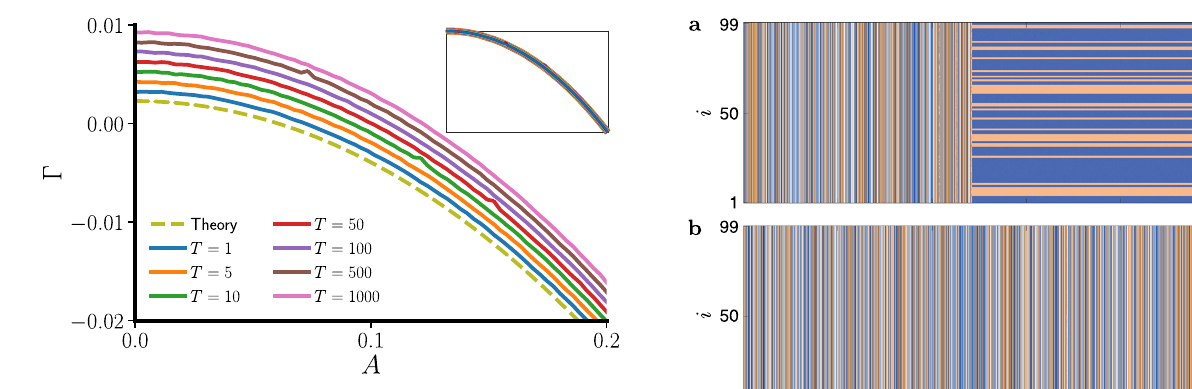
Fig. 5 Temporal networks promote synchronization universally in discrete-time systems with low-dimensional node dynamics. The maximum transverse Lyapunov exponent Γ decreases as the temporal activity A is increased. The dashed line represents the theoretical prediction based on Λ , whereas the solid lines (shifted vertically for visibility) are calculated directly from Eq. (19) for different switching periods T . Without the shift, all curves completely overlap (inset), which con fi rms our prediction that the stabilization provided by temporal networks does not depend on the switching rate for coupled one-dimensional maps.